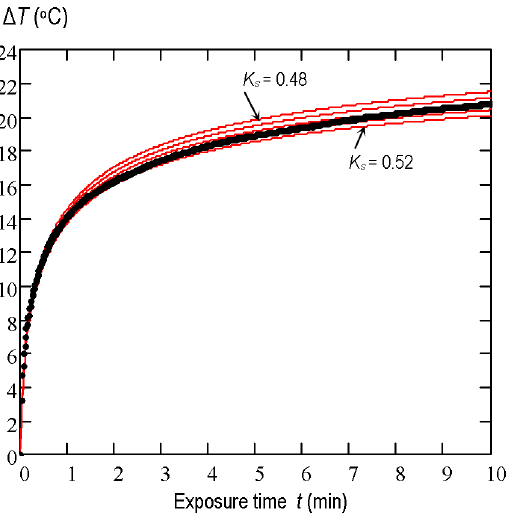
acoustic power by comparison of the temperature-time T ( t ) plots registered by thermocouples. The measured axial position of the each average acoustic power used (0.7 W, 1.4 W and 2.1 W). The